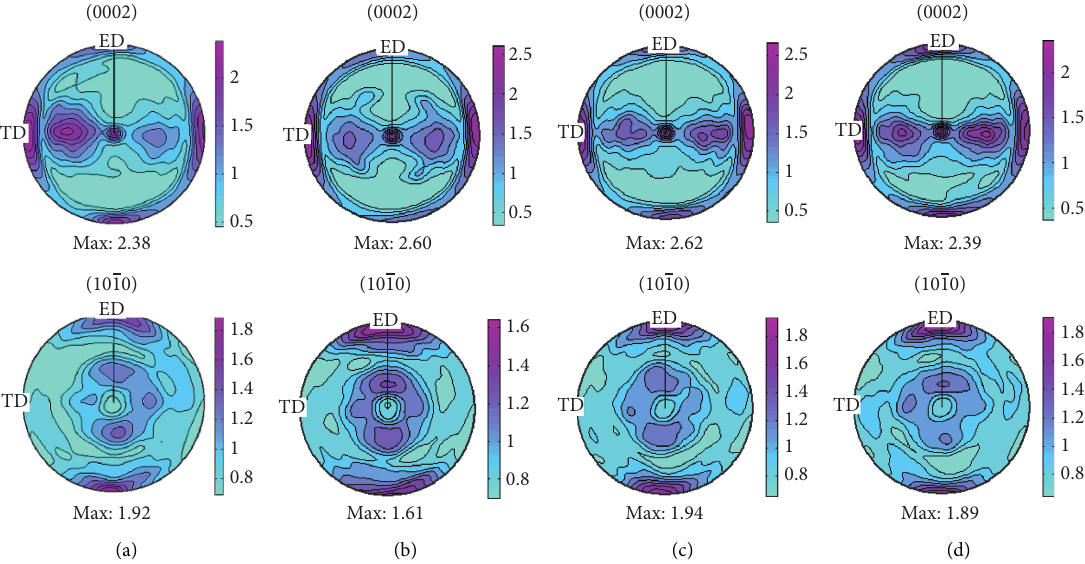
Figure 7: Textures of the as-extruded AZ and AZ-0.3La alloys: (a) AZ31; (b) AZ31-0.3La; (c) AZ80; and (d) AZ80-0.3La.